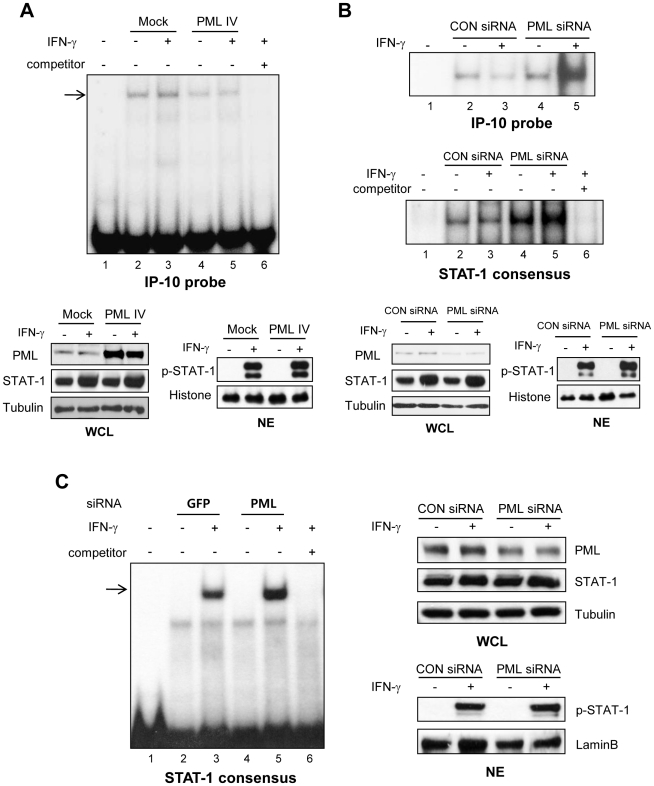
PML Expression Inhibits DNA Binding Activity of STAT-1 to the IP-10 Promoter.(A) Nuclear extracts (NE) from NIH3T3 cells transiently transfected with the PML IV protein expression vector and treated with IFN-γ (10 ng/ml) for 30 min were incubated in the presence of a radiolabeled DNA probe containing the GAS-like element of the IP-10 promoter, and subjected to electrophoretic mobility shift assay (EMSA). Shifted probe-protein complexes are indicated by the arrow. Increased PML protein expression in whole-cell lysates (WCL) transfected with PML IV expression vector was verified by immunoblotting. The amount of histone in NE is shown as a control. (B) NEs from NIH3T3 cells transiently transfected with either Pml siRNA or control siRNA and treated with IFN-γ (10 ng/ml) for 30 min were incubated in the presence of radiolabeled DNA probes containing the GAS-like element of the IP-10 promoter or a STAT-1 consensus sequence, and then subjected to EMSA. Binding specificity was tested by adding increasing concentrations of cold probe (competitor). Effective siRNA-mediated suppression of PML protein expression was verified for each assay by immunoblotting. (C) SNU-638 gastric cancer cells were transiently transfected with either Pml siRNA or control siRNA and treated with IFN-γ (10 ng/ml) for 30 min. NEs were obtained, incubated in the presence of radiolabeled DNA probes containing a STAT-1 consensus sequence, and then analyzed for EMSA as described in B. The levels of PML and STAT-1 protein expression in WCL and the extent of STAT-1 tyrosine phosphorylation in NE were verified by immunoblotting. Data shown are representative of at least three experiments.